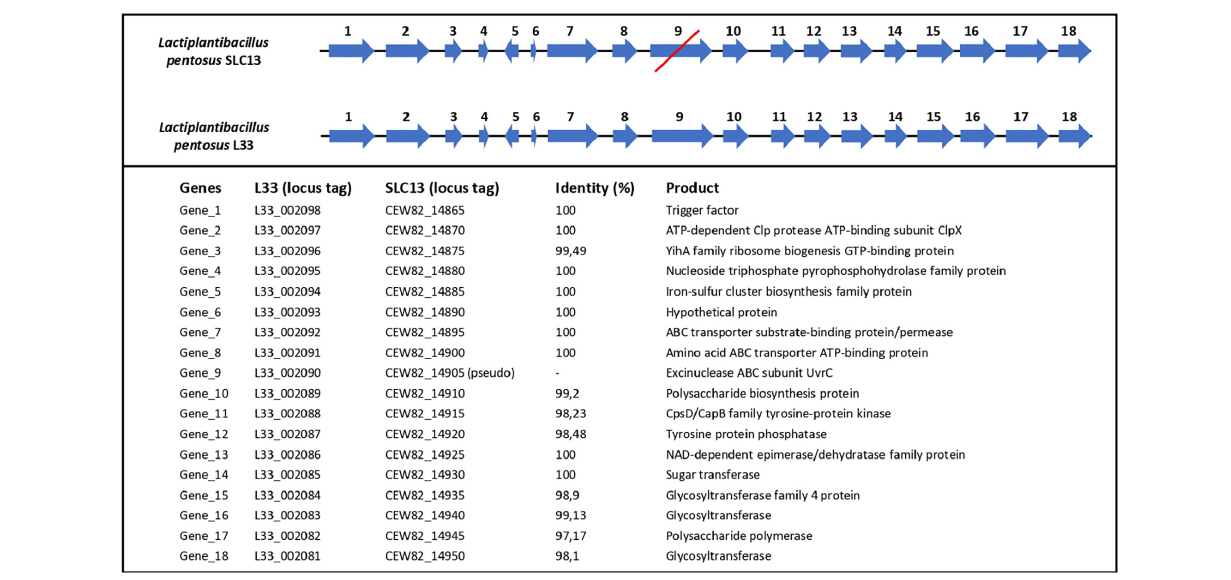
Frontiers in Microbiology |